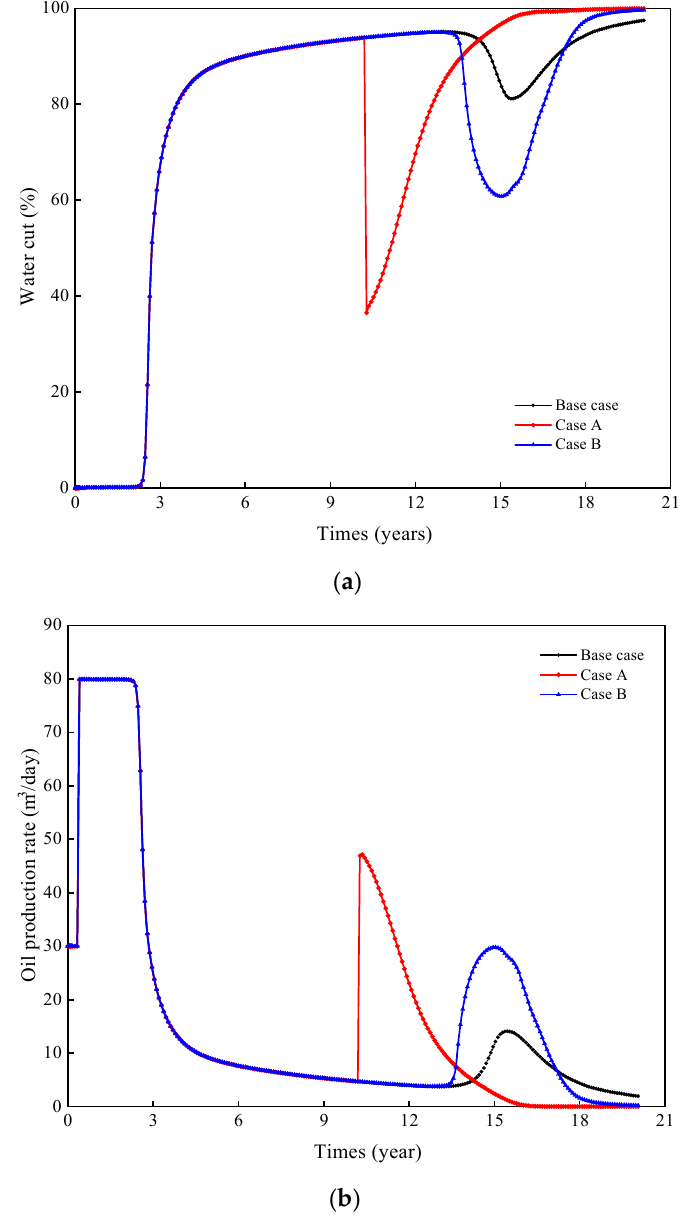
Figure 7. The effect of time variation with polymer concentration interpolation on the PRO01 well performance. ( a ) Water cut. ( b ) Oil production rate.